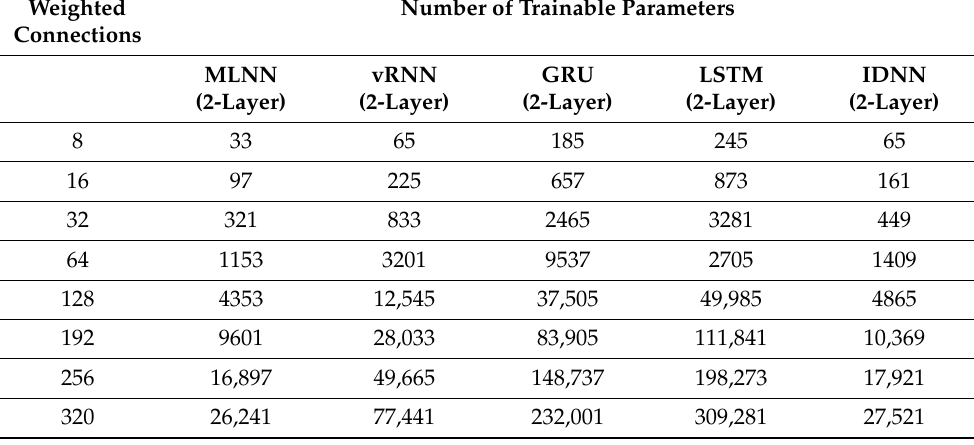
Table 4. Number of trainable parameters in each neural network (NN) across various weighted connections.